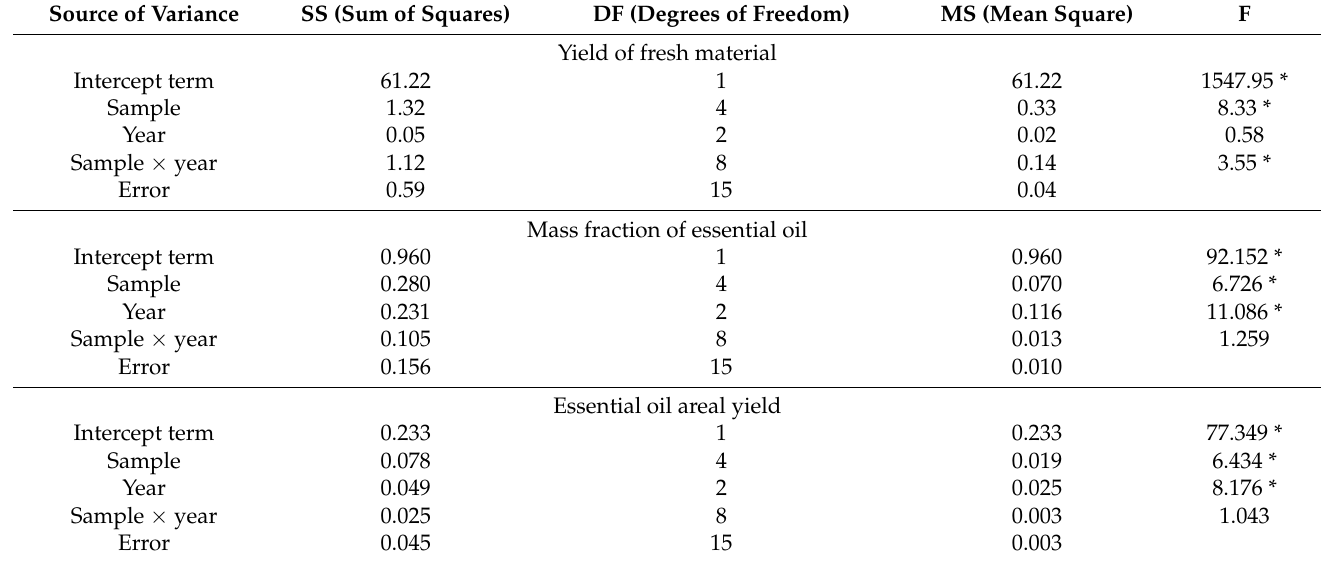
Table 2. Results of a two-way analysis of variance of the main economic traits of oregano